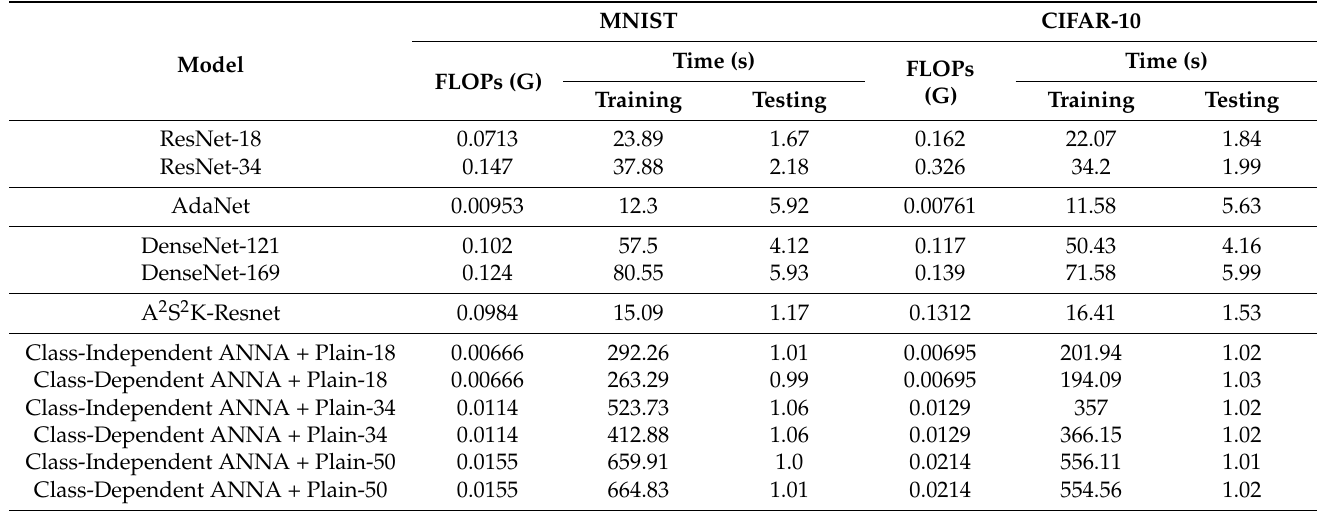
Table 7. Computational complexity and time comparison of ANNA and state-of-the-art approaches on MNIST dataset and CIFAR-10